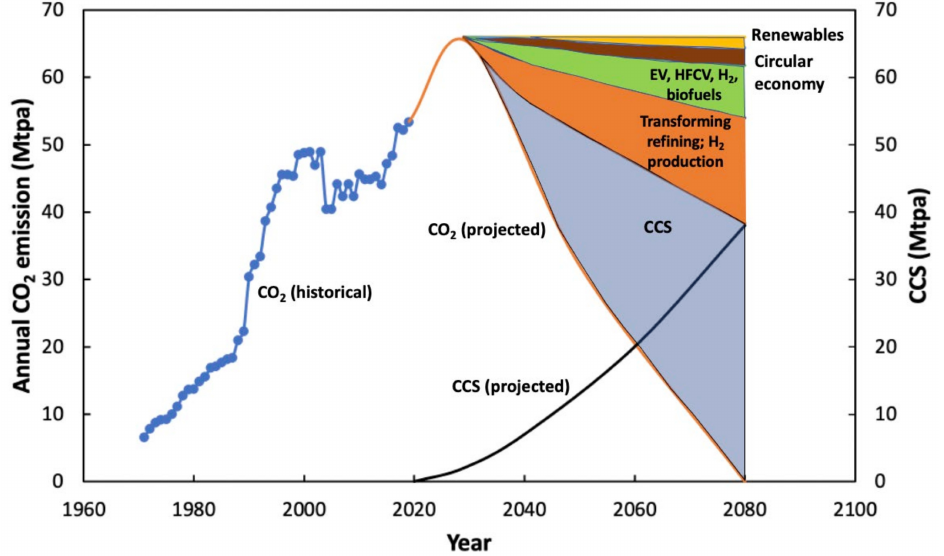
Figure 1. Singapore’s CO 2 emissions and illustrative reductions needed to achieve net-zero emissions by